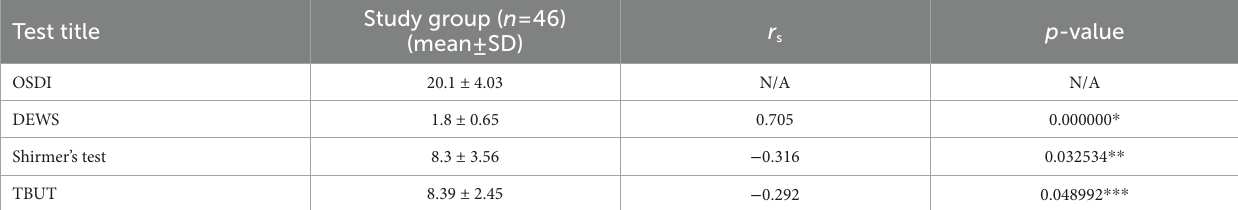
TABLE 5 Correlations between OSDI and objective tests in the study group.